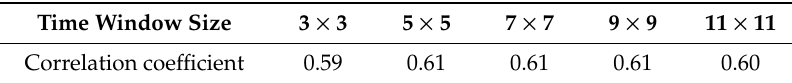
Table 1. Correlation coe ffi cient for di ff erent time windows without